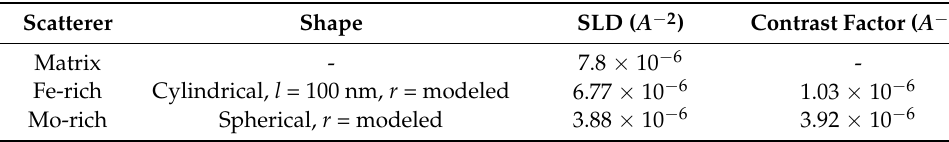
Figure 2. Driving simulator—smartwatch.